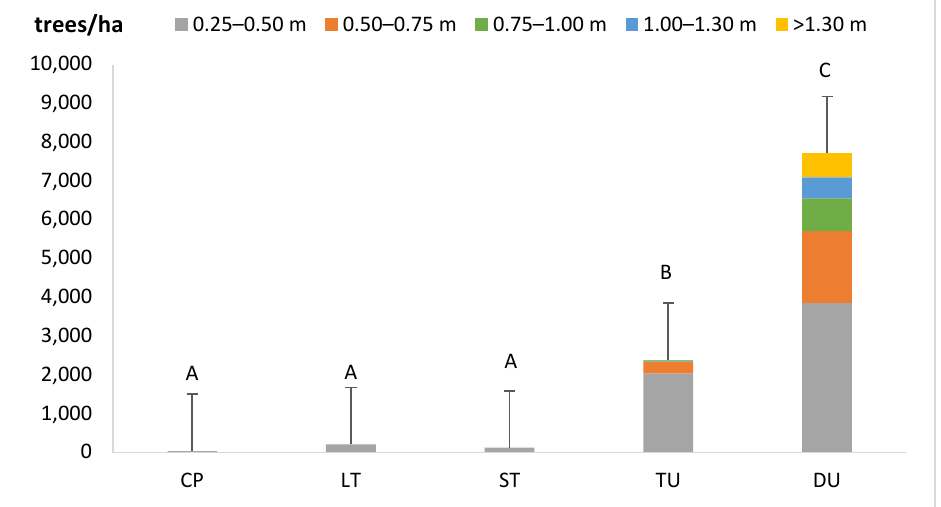
Figure 9. Density of juveniles above 0.25 m (as parameter for measuring regeneration) in the plots of each treatment and classified by height ranges. Different capital letters indicate significant differences among treatments.